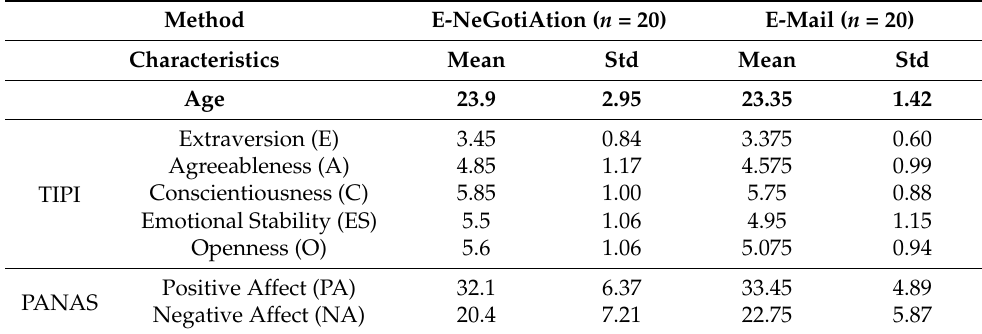
Table 3. Mean and standard deviations for personality measures and